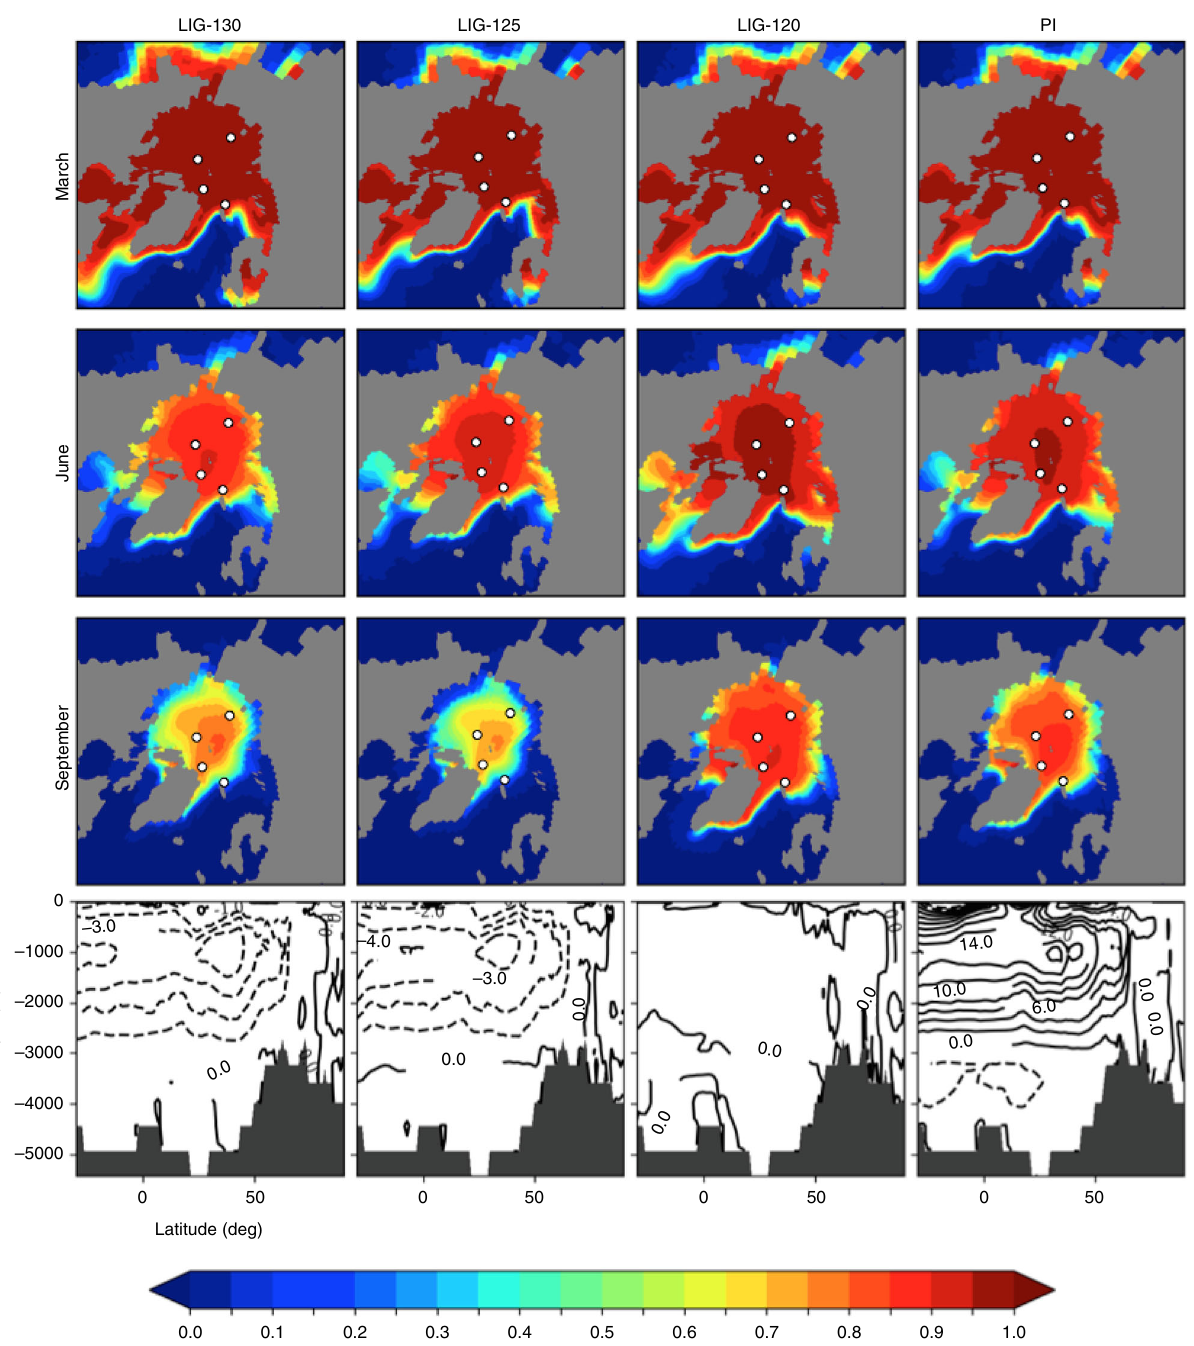
Fig. 4 Simulation of Arctic sea ice cover of the Last Interglacial and the pre-industrial climate. Last Interglacial ( LIG ) conditions were simulated for three time slices: LIG-130 (130 ka), LIG-125 (125 ka), and LIG-120 (120 ka). White circles indicate locations of the four studied sediment cores. The Atlantic Meridional Overturning Circulation ( AMOC ) is shown in the lower panels of Fig. 4 for each time slice. For the PI, numbers indicate absolute Sv values whereas the numbers in the LIG runs are Sv anomalies relative to the PI values (i.e., -3.0 means a reduction of three Sv in comparison to the PI value). The AMOC during LIG-130 and LIG-125 is reduced compared to the Pre-Industrial ( PI ) control runs. The increase in AMOC at 120 ka relative to the 125 ka leads to an increased oceanic heat transport and partly compensates for the decrease in